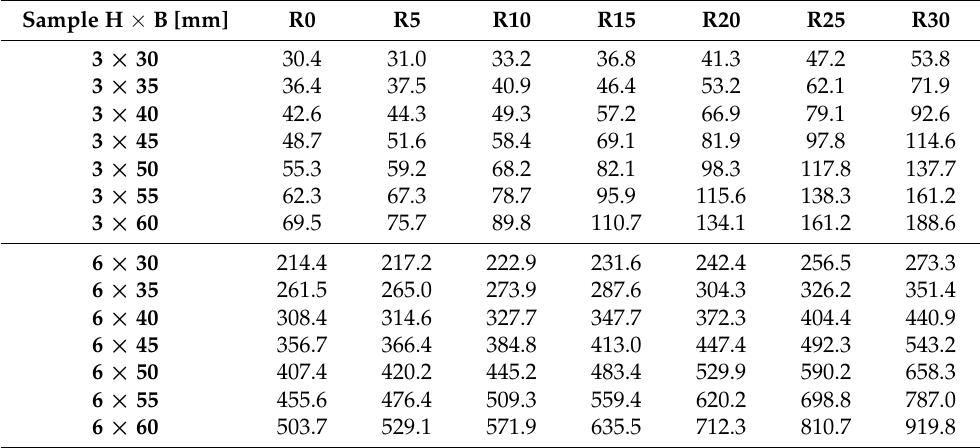
Table 1. Results of numerical simulations. Torsional moment [Nm] for 20 ◦ twist, depending on the package’s cross-section dimensions (H × B) and the expansion R [mm].